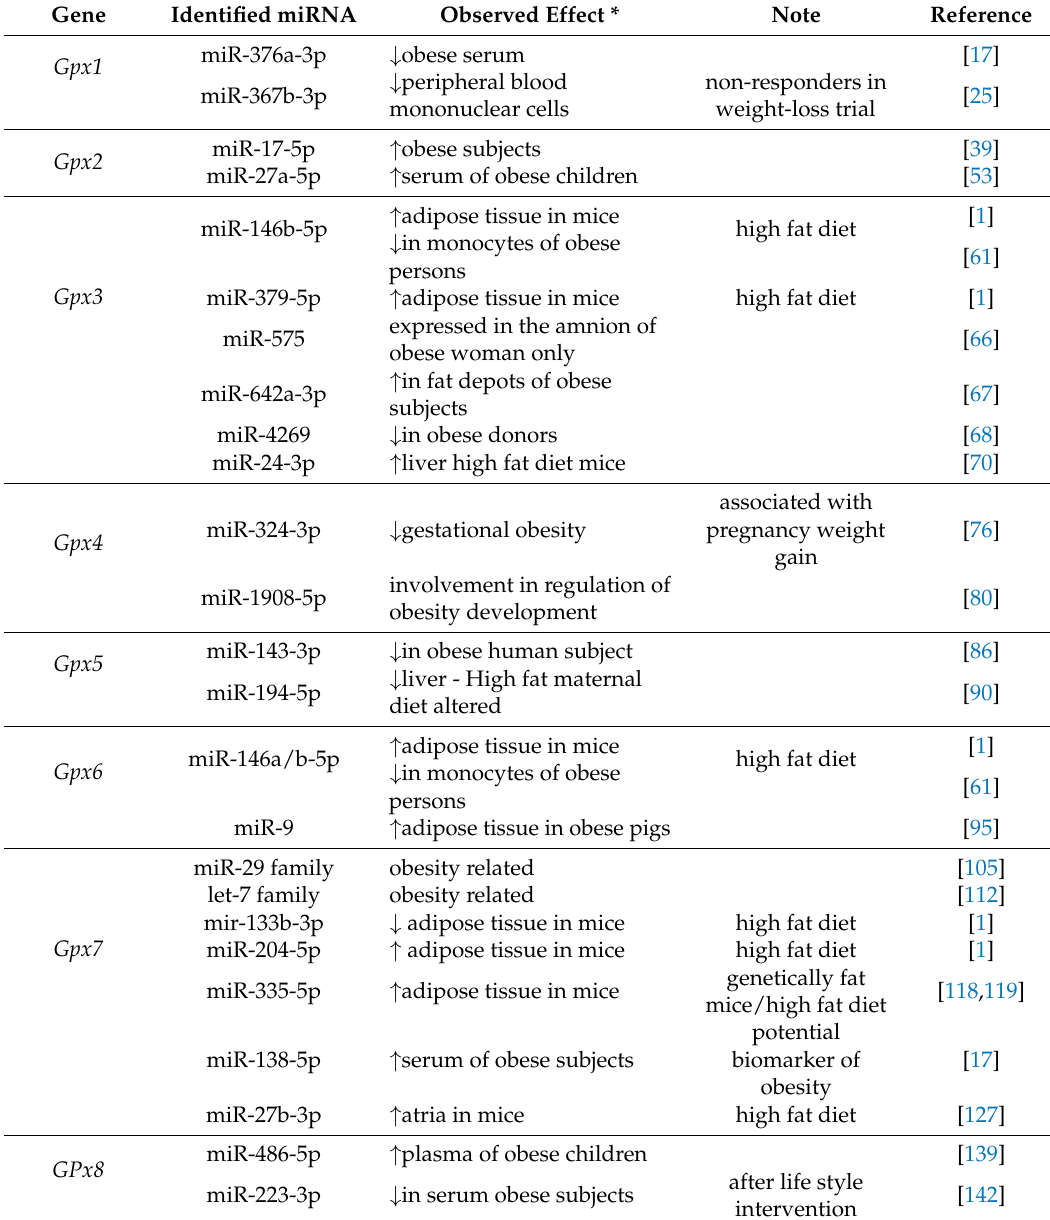
Table 2. List of identified miRNAs as putative regulators of respective GPxs with reported obesity